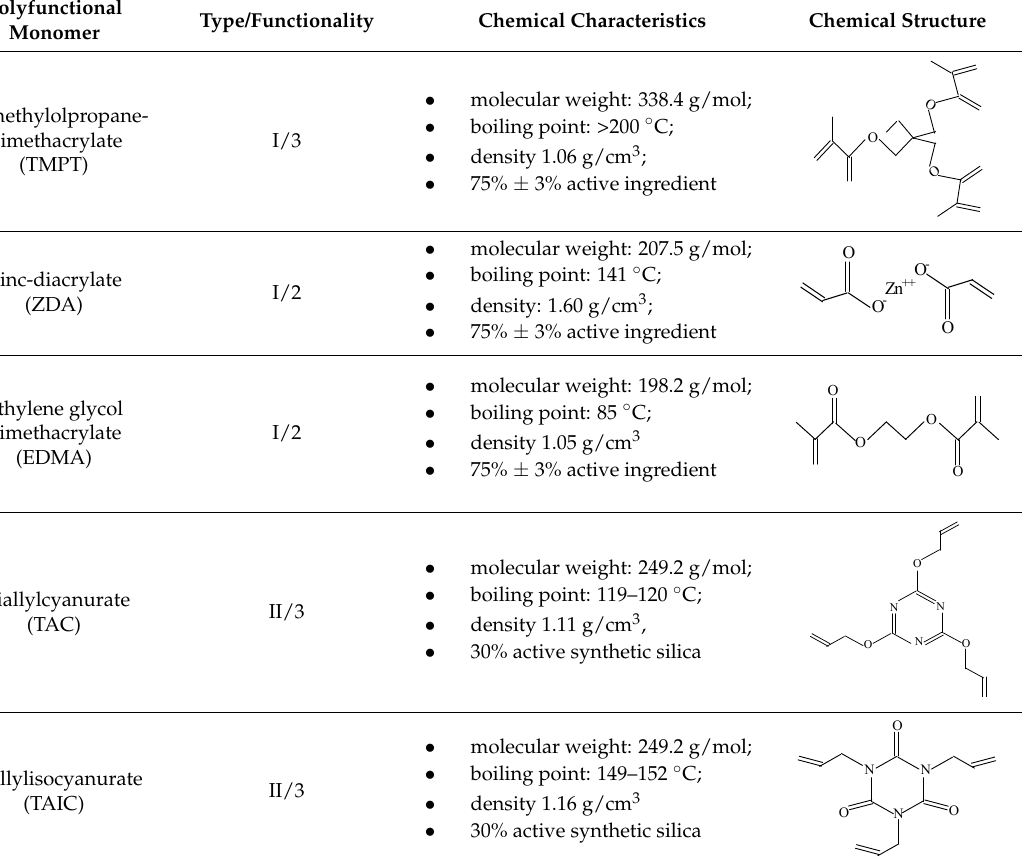
Table 1. Comparison between chemical structures and characteristics of polyfunctional monomers that have been used.